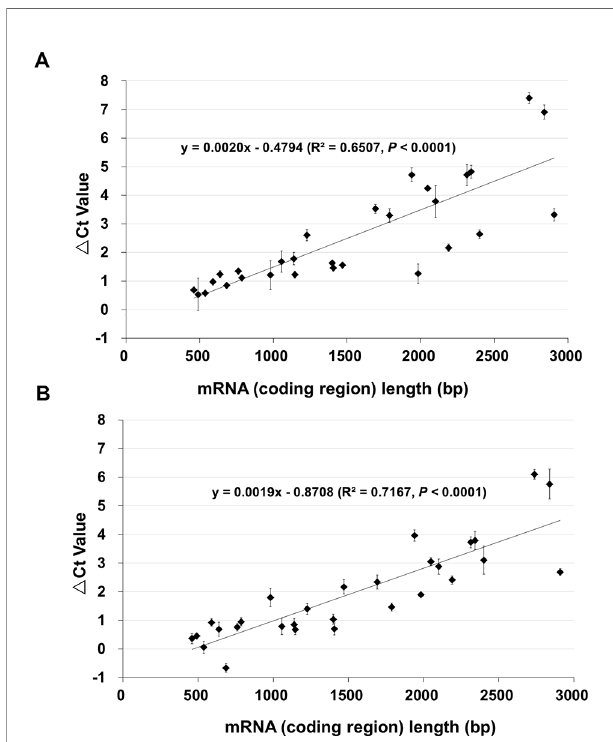
FIGURE 2 | The relationship between the length of stored mRNAs and D Ct value in qPCR analysis. cDNAs of unaged control, AA (arti fi cially aged, 0.5% germination) and NA (naturally aged, 0.5% germination) seeds were used. qPCR analysis was conducted for 29 genes which differ in the cDNA (coding region) length. For each gene, the difference in the Ct value between the aged and control samples was obtained as D Ct = Ct of the aged sample – Ct of control. Each D Ct value was the average of three biological repeats (with the standard error shown). (A) D Ct values of 29 genes between the AA and control seeds, and the correlation with the cDNA length. (B) D Ct values of 29 genes between the NA and control seeds, and the correlation with the cDNA length. The linear regressions were produced with Microsoft Excel 2010 and both have a P <